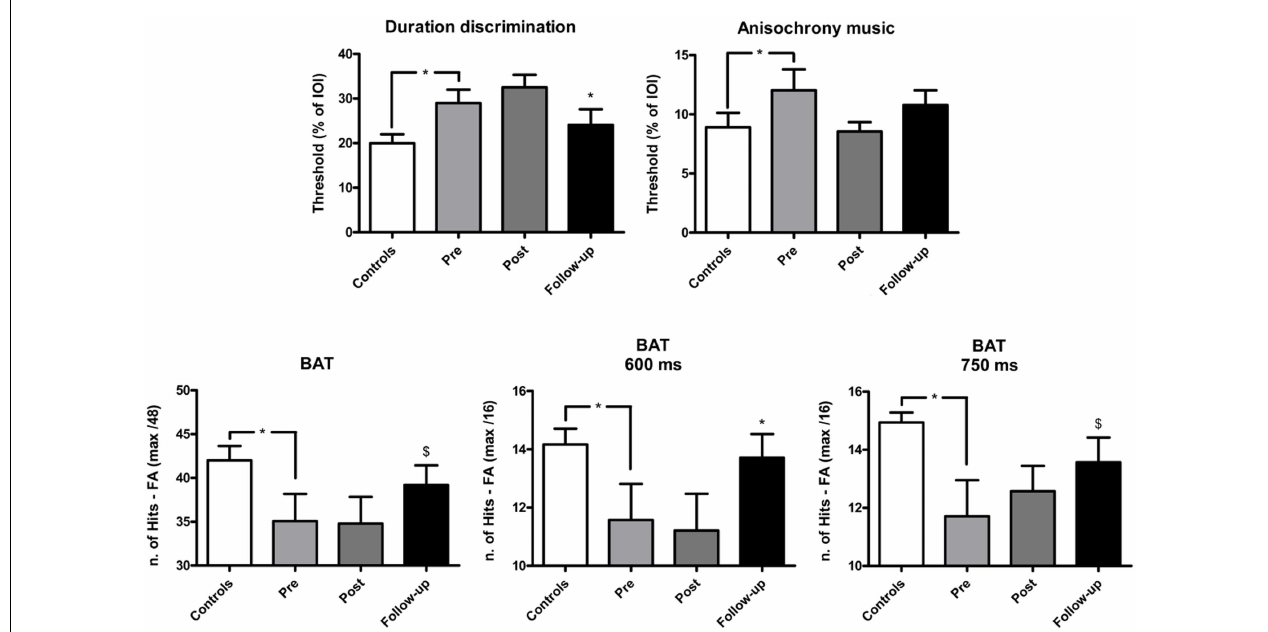
FIGURE 1 | Mean performance of IPD patients and controls in the perceptual tasks of the BAASTA .Tasks where patients differed from controls before the cueing training are selectively reported. Error bars indicate the standard error of the mean (SEM). Note: * p < 0.05; $ marginally significant difference.